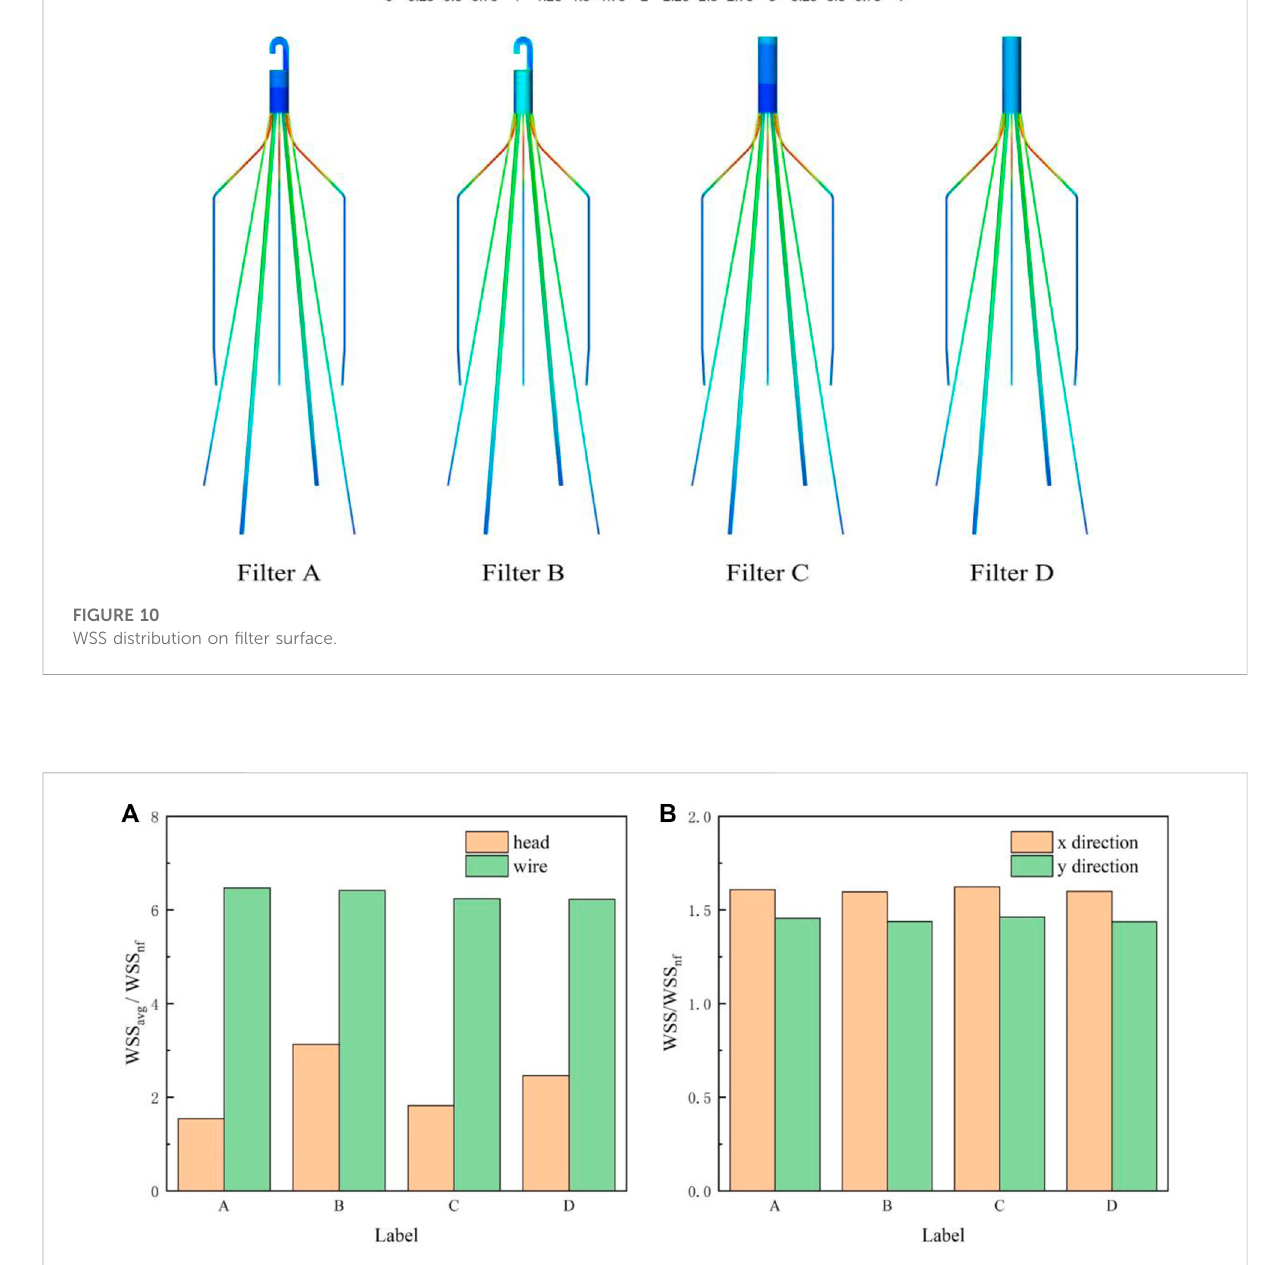
(López et al., 2018). The results further con fi rmed the existence of a stagnant zone downstream the fi lter head. Virchow ’ s triad indicates that three risk factors consisting of blood fl ow stasis, blood hypercoagulability, and endothelial damage may predispose patients to venous thrombosis